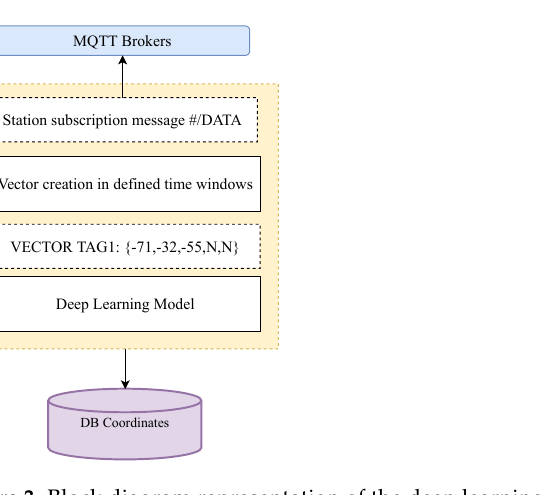
Figure 3. Block diagram representation of the deep learning layer (taken from